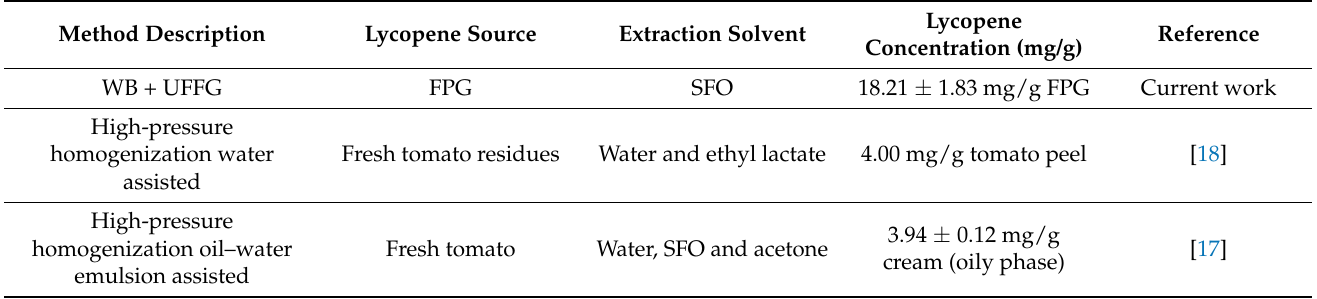
Figure 4. Lycopene isolation yield. Comparison between mechanical treatments and conventional treatments. Table 3. Comparison of the amount of lycopene recovered from FPG by WB + UFFG 1:20 (this work) with literature data, where different mechanical treatments and solvents were